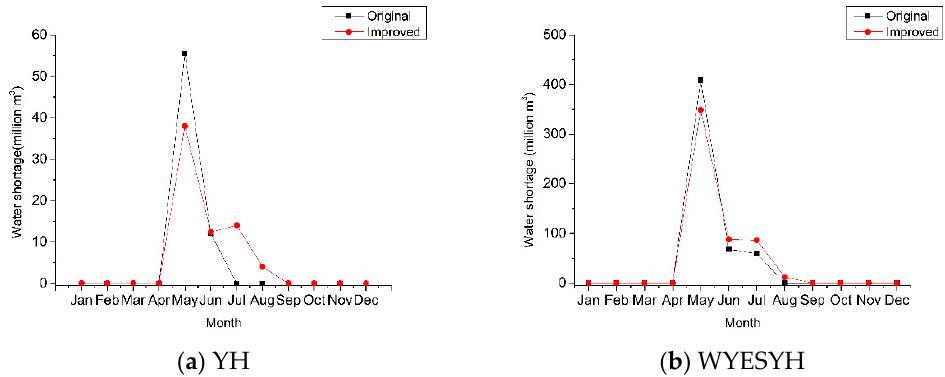
Figure 6. Changes in agricultural water shortage at a precipitation frequency of 75%.